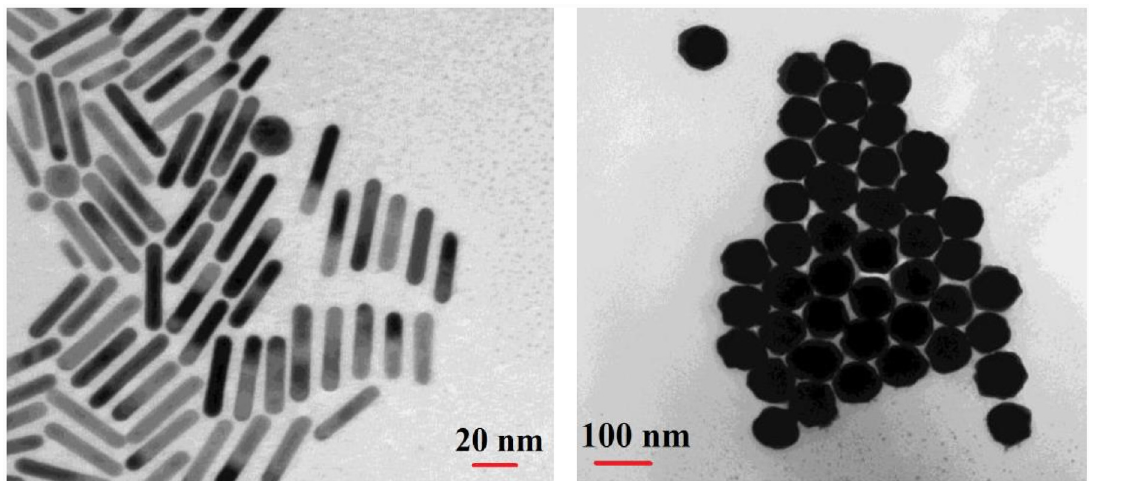
Fig 3. Example TEM images of the studies GNPs: NR6 (left), and NS5 (right) as introduced in Table 1.